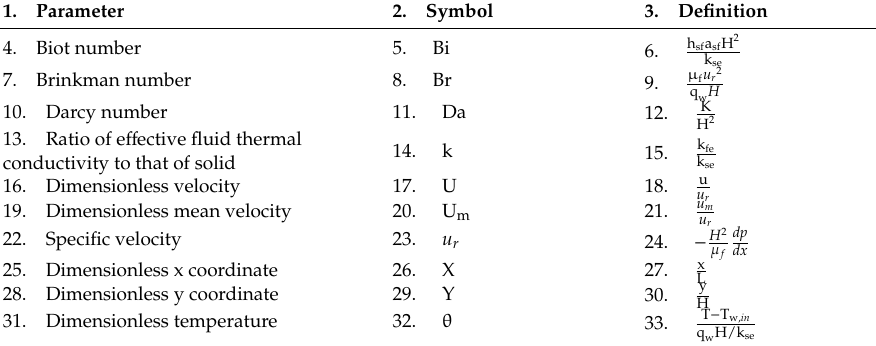
Table 1. Summary of the dimensionless parameters employed in the present work